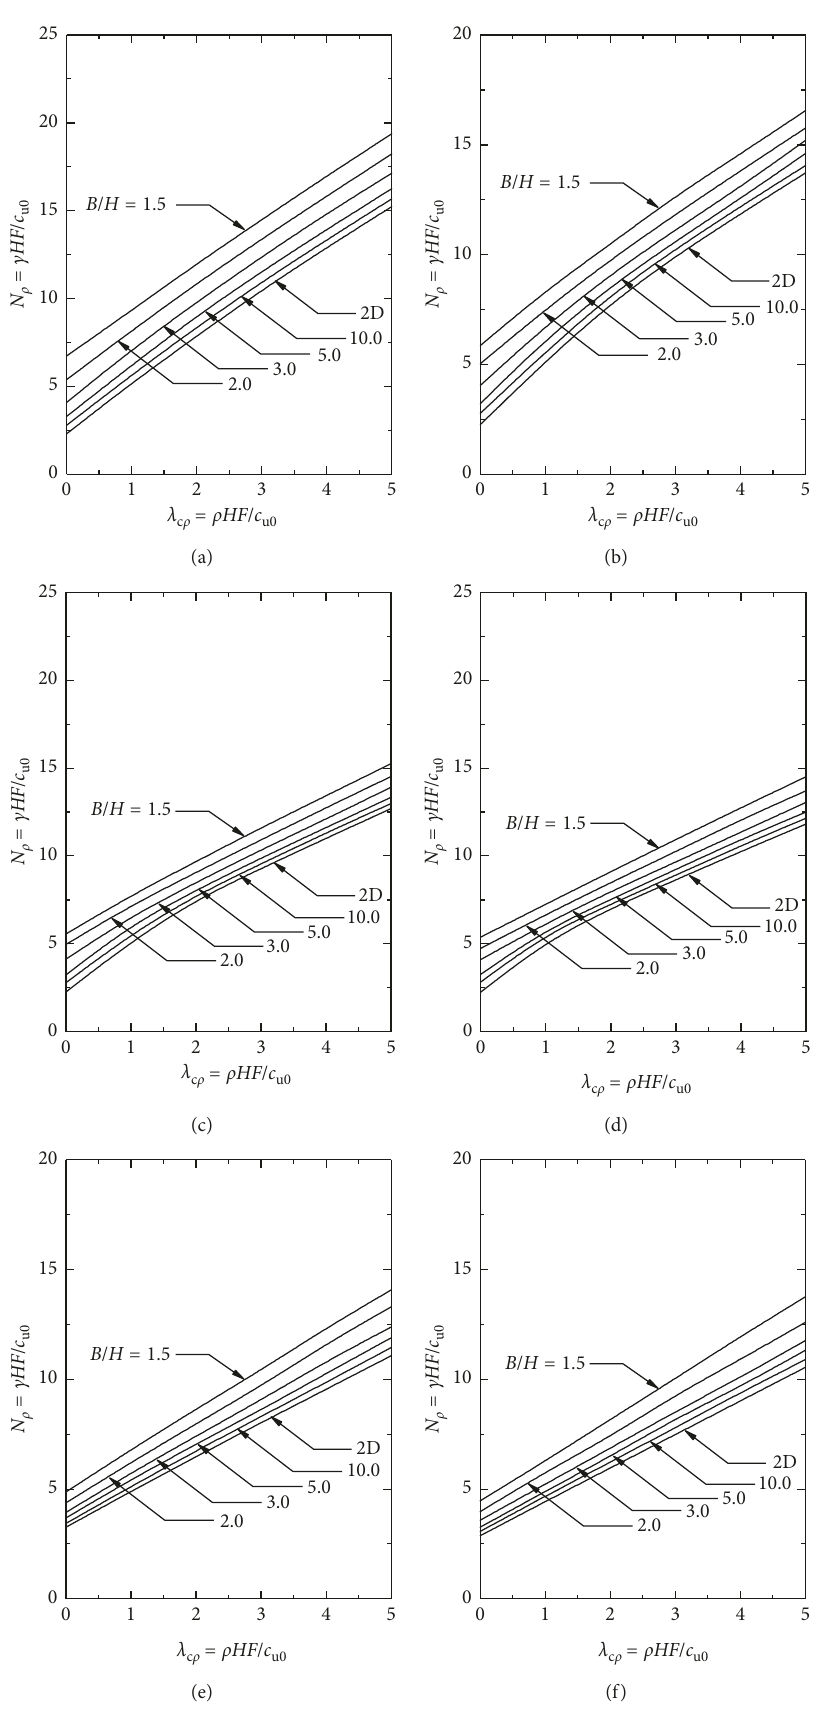
Figure 12: Seismic stability charts for natural slopes with k